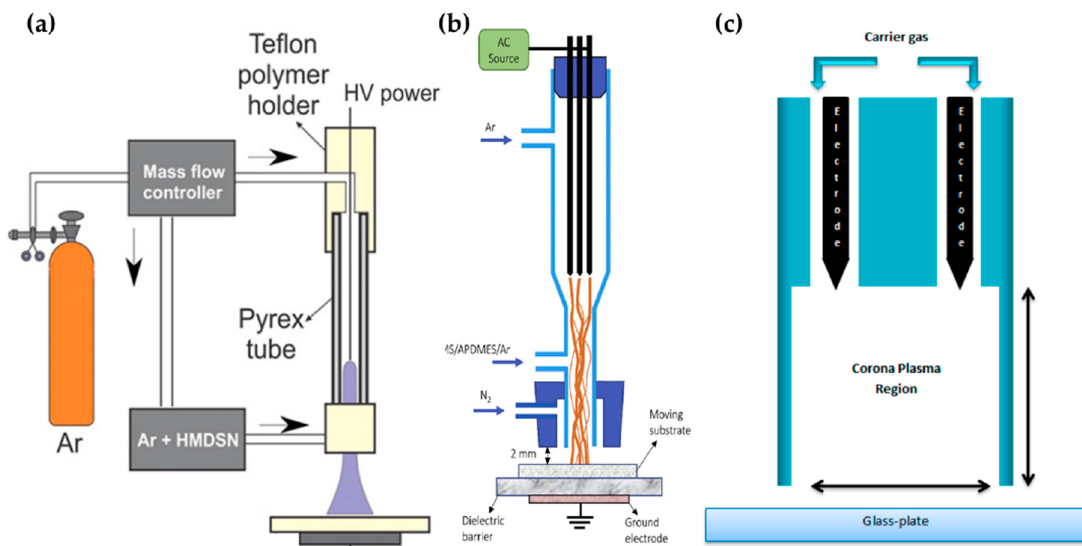
Figure 3. Structures of pin electrode type in the APPJs of ( a ) Kodaira et al. [56], ( b ) Hossain et al. [57], and ( c ) Malinowski et al.